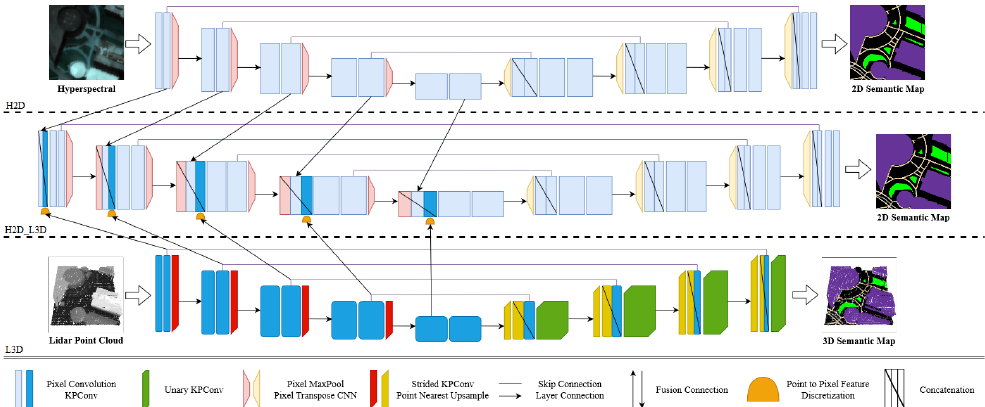
Figure 6. Point convolution-based networks, H2D is pictured again. ( Top ) H2D ingesting raw hyperspectral data and predicting a 2D semantic map. ( Bottom ) L3D ingesting a lidar point cloud and predicting a 3D semantic map utilizing KPConv layers for processing as originally described by [20]. ( Center ) H2D_L3D ingesting low- and high-level unimodal hyperspectral and lidar features via fusion connections from H2D and L3D and predicting a 2D semantic map. H2D_L3D is constructed as a composite style fusion architecture inspired by